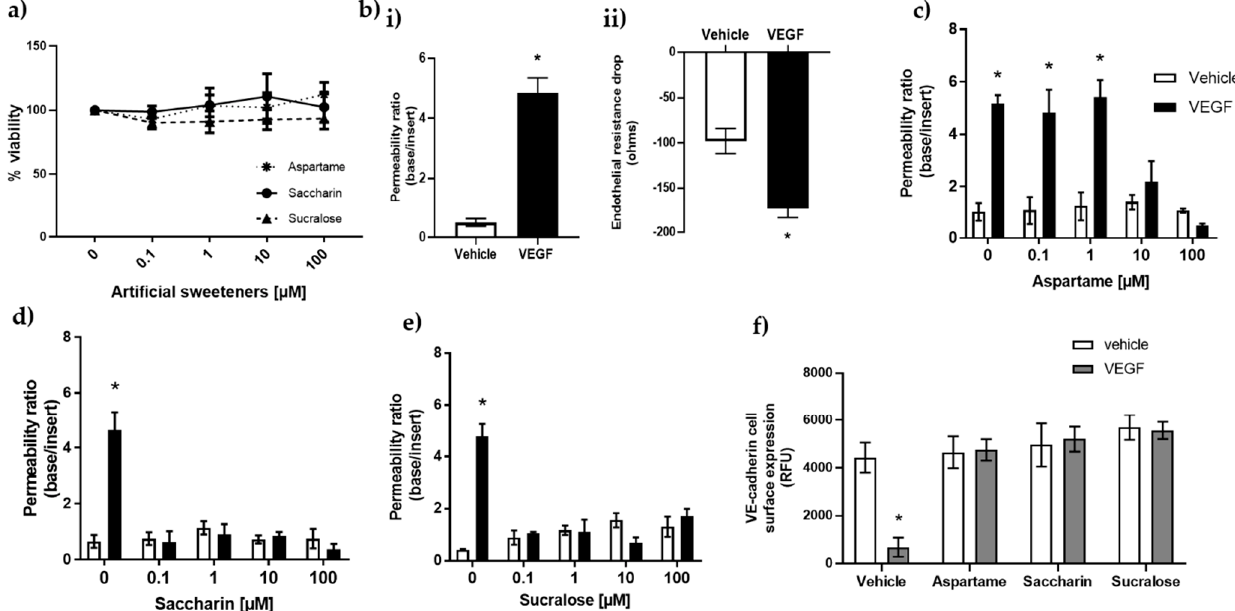
Figure 1. Artificial sweeteners, saccharin and sucralose, attenuate VEGF-induced leak across the glomerular microvas- culature. Panel ( a ): viability of GMVEC, determined using a CCK-8 assay following exposure to artificial sweeteners, aspartame, saccharin, and sucralose, at physiologically relevant concentrations of 0.1–100 µM. Panel ( b ): effect of VEGF (50 ng/mL, 4 h) on permeability of GMVEC monolayers measured with FITC-dextran assay panel ( bi ) and validated by TEER panel ( bii ). Panel ( c – e ): protection of GMVEC monolayer following exposure to aspartame ( c ), saccharin ( d ), and sucralose ( e ) against VEGF-induced leak. Panel ( f ): effect of aspartame, saccharin, and sucralose on surface-level expression of VE-cadherin in the presence and absence of VEGF. Data are presented as mean with S.E.M and n = 6. * p < 0.05 vs. vehicle.